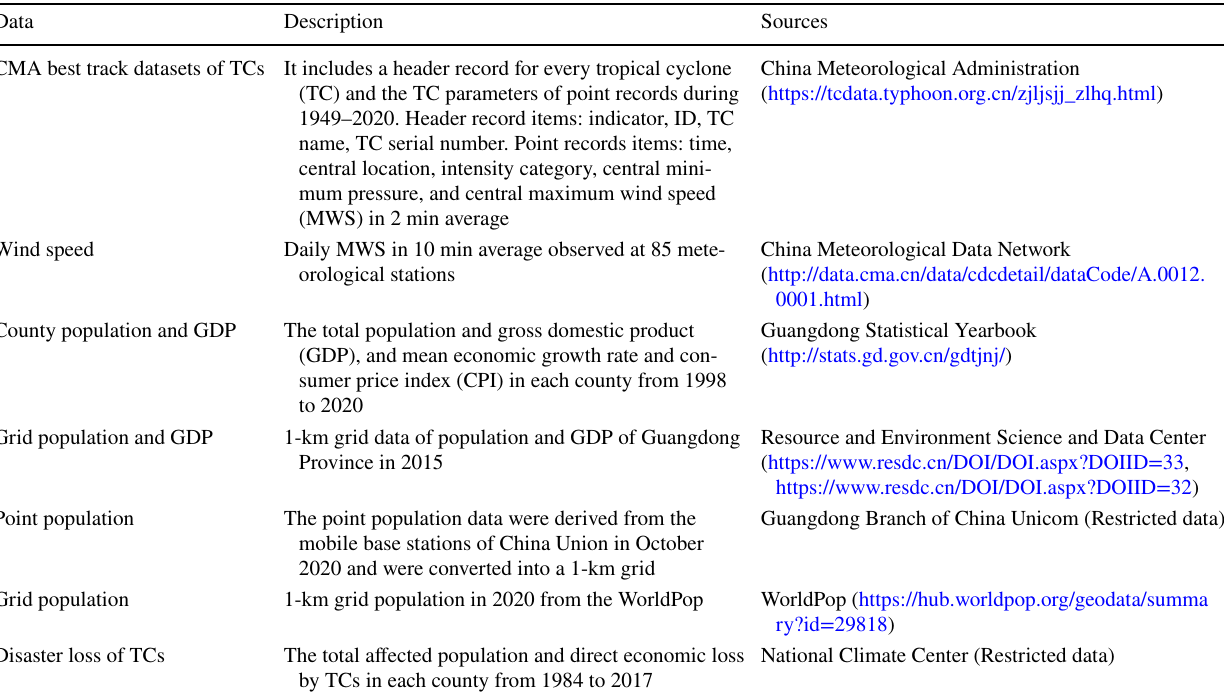
Table 1 Data description and sources for tropical cyclone damage prediction and risk assessment in Guangdong Province, South China